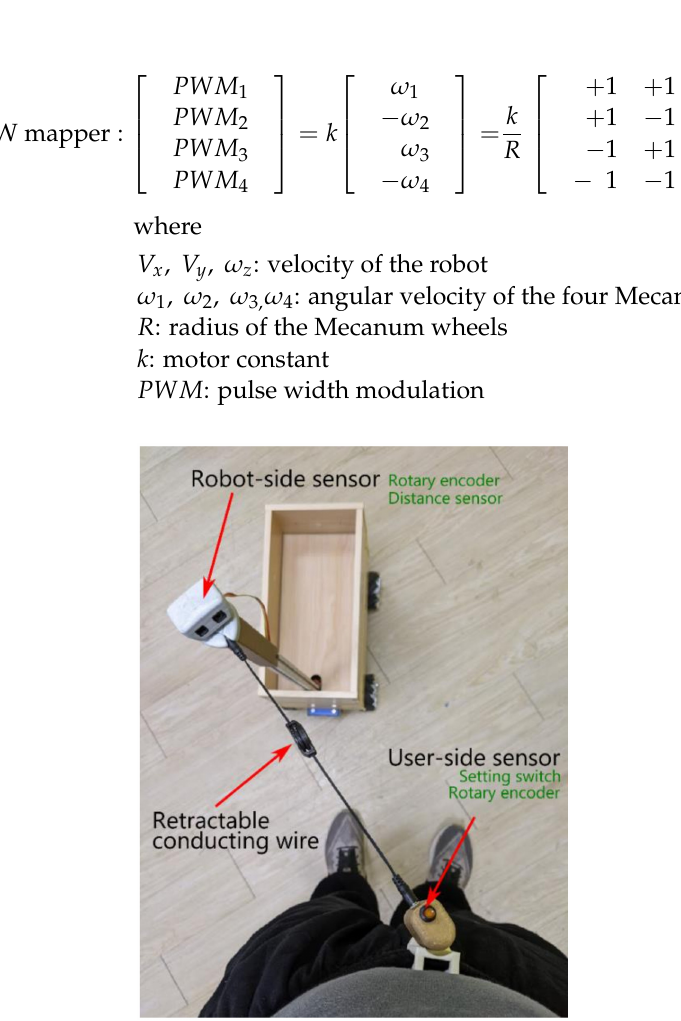
Figure 2. “String-pots” to sense LCS U and LCS R .